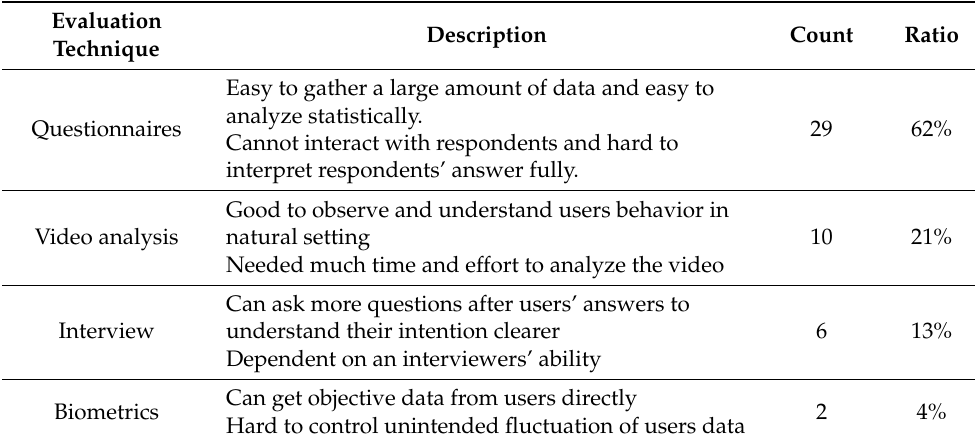
Table 2. Summary of evaluation